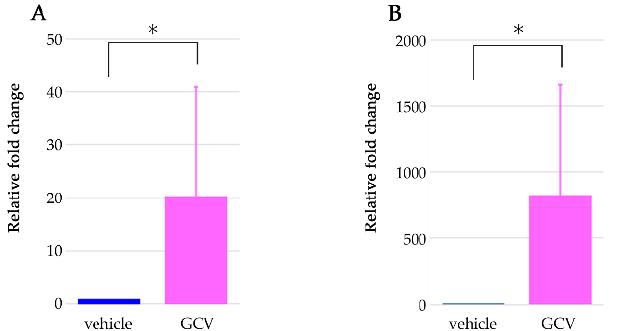
Figure 7. Expression levels of T-cell related genes. Gene expression of CD4 ( A ) and CD8 ( B ) in vehicle-treated skin (blue bars, n = 4) and GCV-applied skin (pink bars, n = 4) of Tg rats at 7 days. Data are mean ± SEM. * p < 0.05.